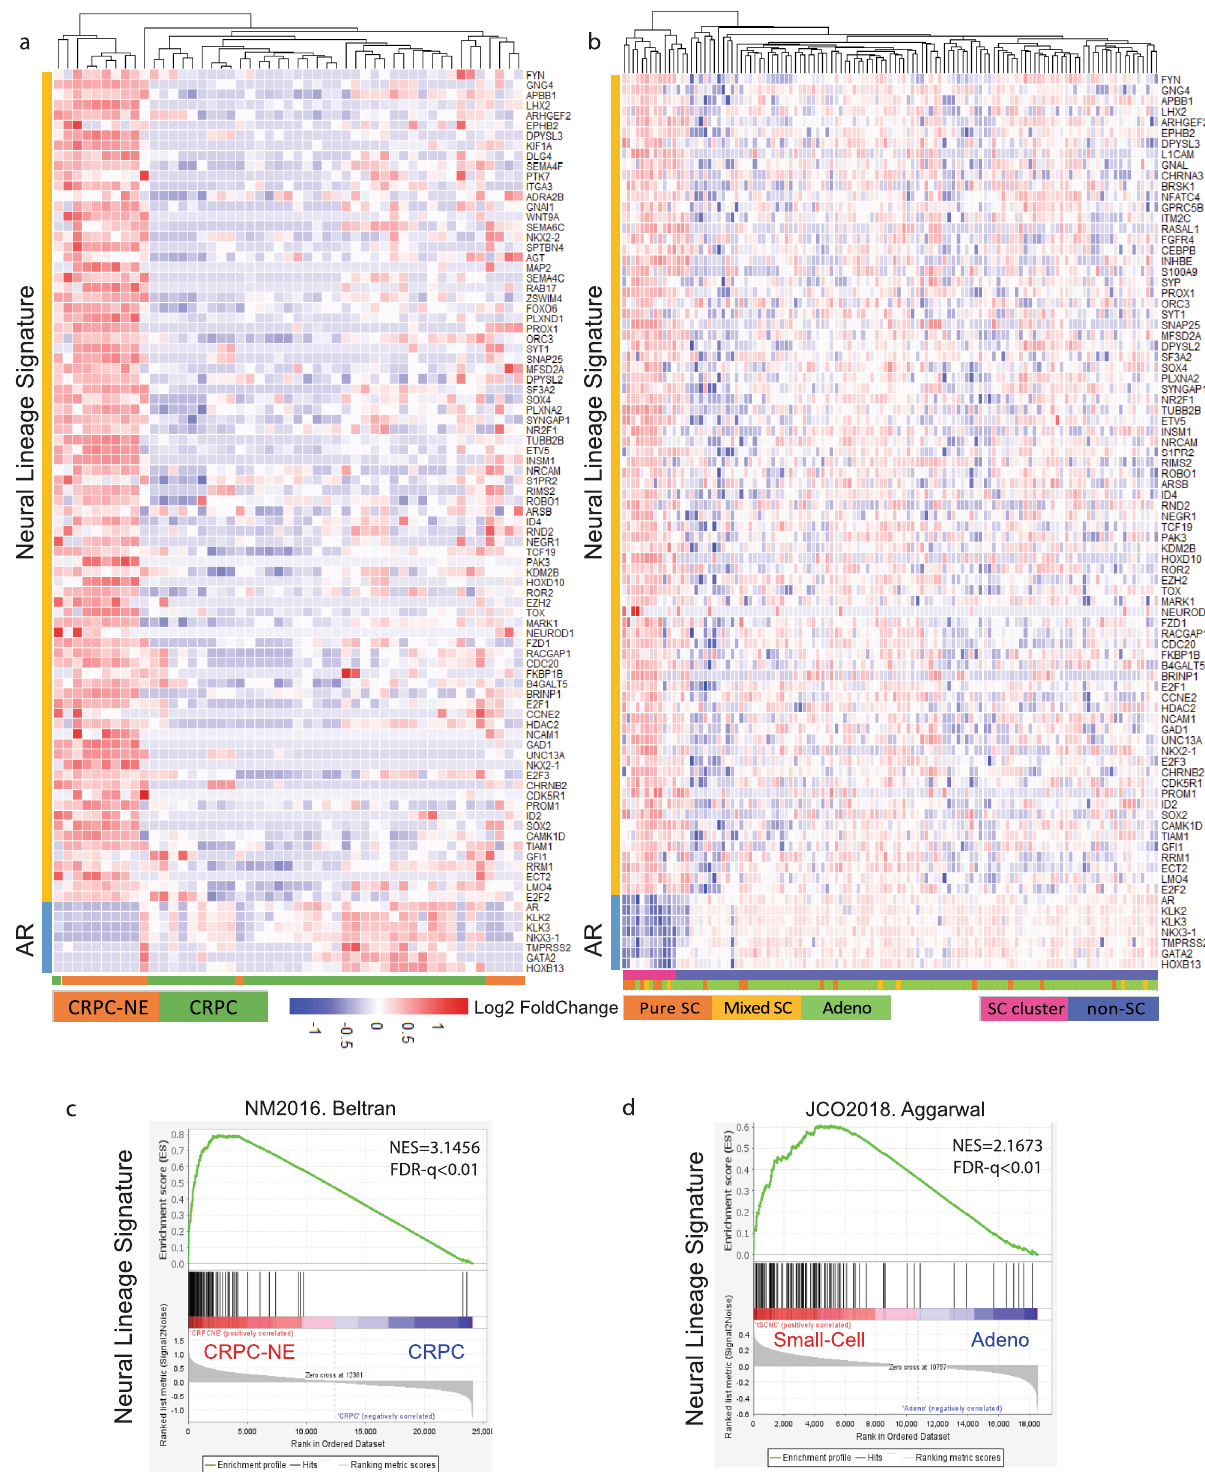
Fig. 3 Identi fi ed neural lineage signature genes upregulated in CRPC-NE patients. a Unsupervised hierarchical cluster of 95 differentially genes expressed in Beltran CRPC-NE cohorts. Pathology classi fi cation (CRPC vs. CRPC-NE) is indicated in the annotated track next to the heatmap. b GSEA enrichment plots with NES scores and FDR q values shown. *FDR q value <0.05, **FDR q value <0.01, ***FDR q value <0.001. c Hierarchical cluster analysis of 95 differentially expressed neural lineage genes in Aggarwal t-SCNC cohorts. Pathology classi fi cation (Pure/Mixed small cell/Adenocarcinoma) and molecular cluster of small-cell and non-small-cell groups is indicated in the annotation track next to the heatmap. d Enrichment plots for neural lineage signature in Aggarwal t-SCNC cohorts with NES scores and FDR q values shown. *FDR q value <0.05, **FDR q value <0.01, ***FDR q value <0.001. CRPC castration-resistant prostate cancer, CRPC-NE castration-resistant prostate cancer with neuroendocrine features, GSEA Gene Set Enrichment Analysis, NES normalized enrichment